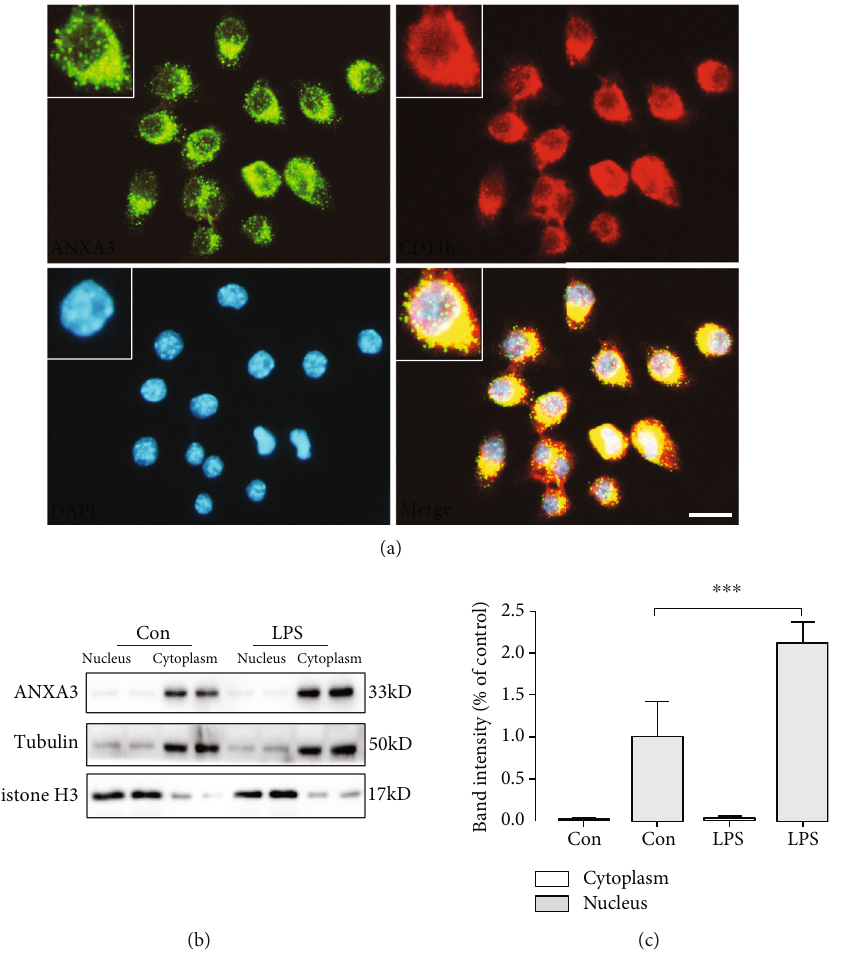
Figure 7: Subcellular localization of ANXA3 in resting and activated N9 microglial cells and lentiviral transfection of N9 cells. (a) Representative immuno fl uorescence images showing ANXA3 expression in microglial cells. N9 cells were also stained for CD11b expression. The inset shows the microglia at a higher magni fi cation. Scale bar = 40 μ m . (b, c) Western blotting analysis of ANXA3 protein expression levels in the cytoplasm and nuclei of resting (Con) and LPS-induced activated microglia (500ng/ml LPS treatment for 24 hours). The panel shows the ANXA3, tubulin, and histone H3 protein bands, and the histogram re fl ects the results of the densitometric analysis. The data are expressed as the means ± SD and were analyzed by Student ’ s t -tests. ∗∗∗ p < 0 : 001 compared with the control group. The data were pooled from six independent